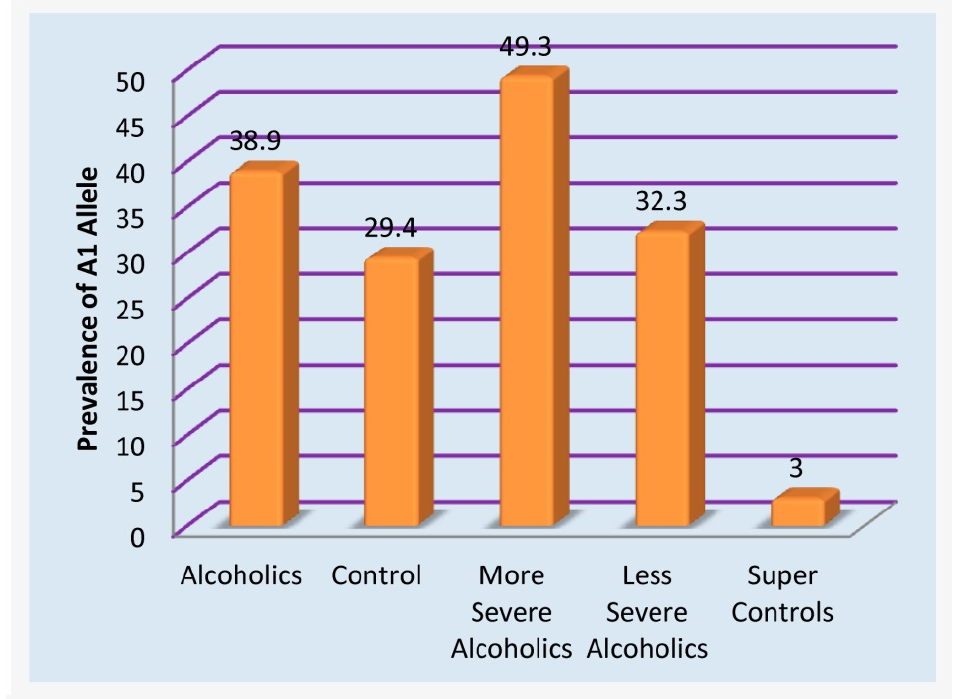
Figure 2. Prevalence of DRD2 A1 allele in unscreened and RDS Free controls. RDS a